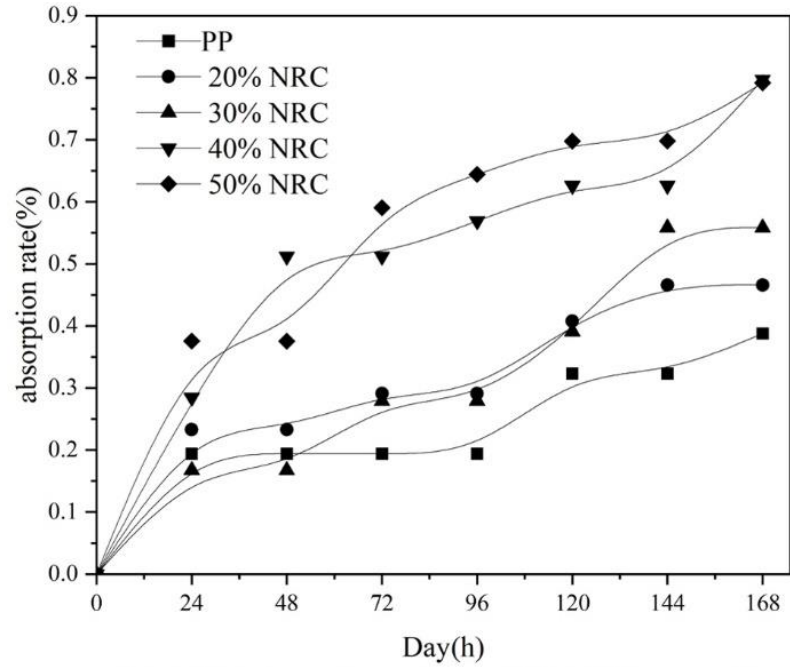
Figure 3. Moisture absorption of RC/PP Composites.